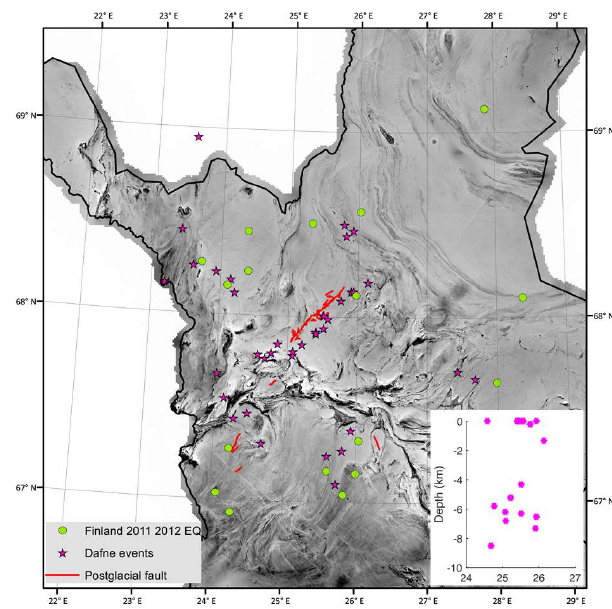
Figure 3. Epicentres of local earthquakes (magenta stars) identi- fied from recordings of the DAFNE/FINLAND temporary during September 2011–May 2012 shown on the aeromagnetic map of Fin- land. Epicentres of local earthquakes detected by regional seismic networks in Fennoscandia during September 2011–May 2012 are shown with green dots. Red lines indicate postglacial faults in the area. Right corner inset shows depth distribution of the events orig- inating from the SPGF area. Precision of hypocentre coordinate de- termination is of the order of 2–5km. The average error of depth determination is about